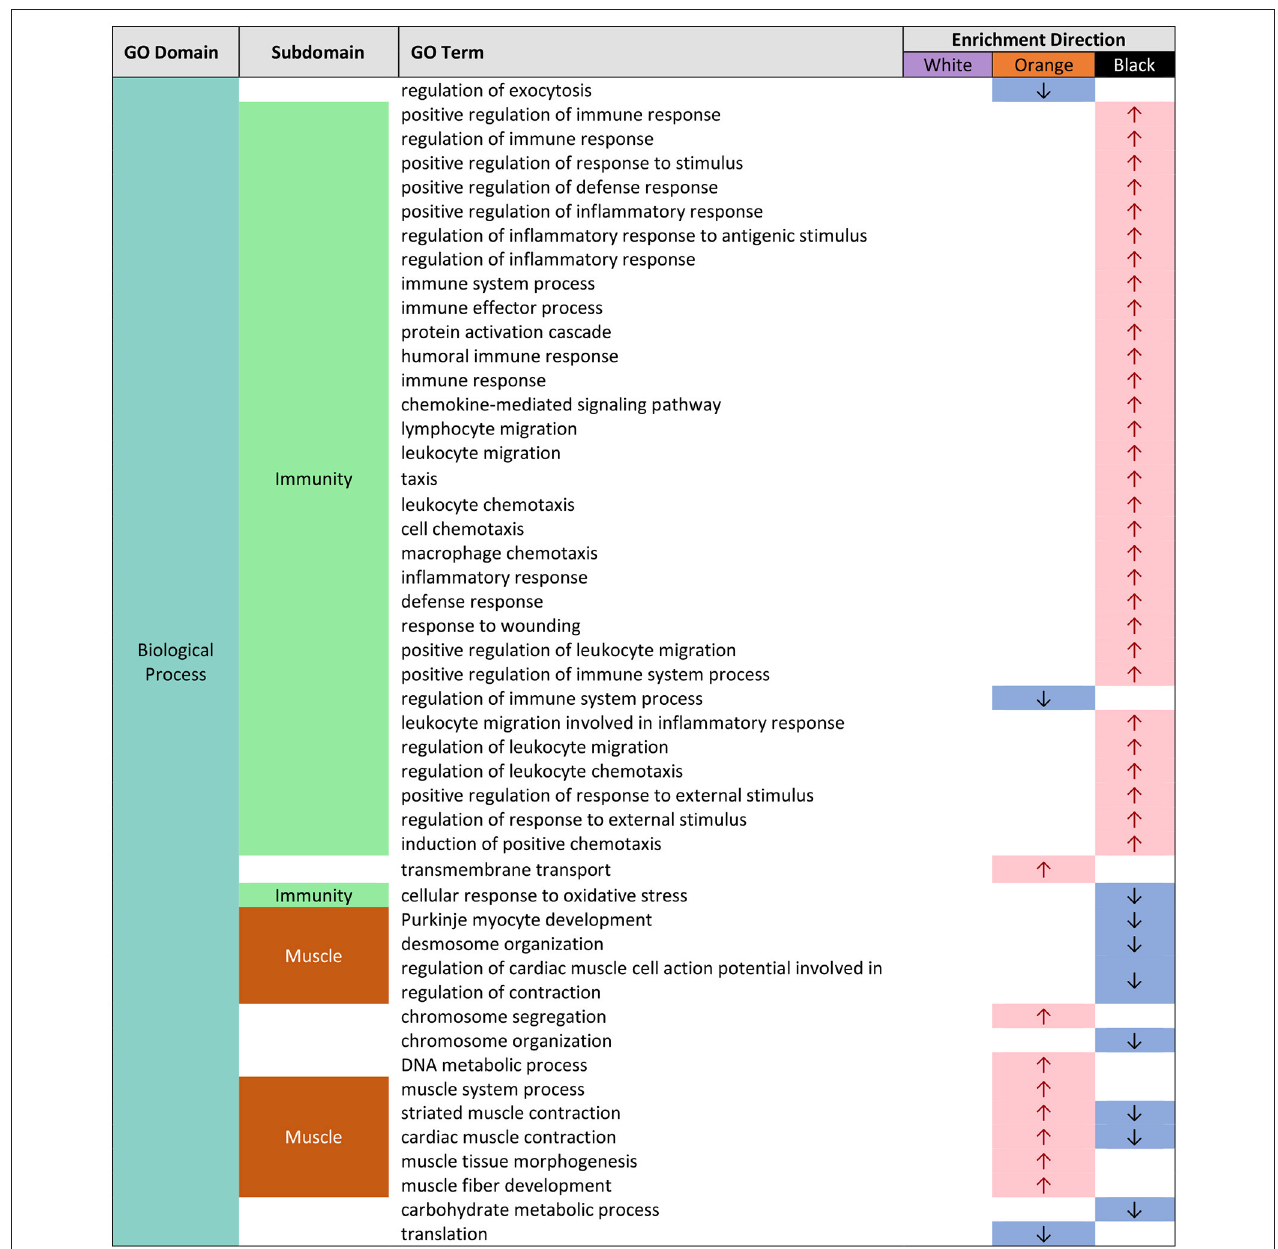
FIGURE 2 | Gene ontology (GO) categories significantly enriched for both pairwise color comparisons for each epidermal tissue by “biological process” (BP) using Mann-Whitney U tests based on ranking of signed log p -values computed using EdgeR . Results indicate the GO domain (BP), the subdomains discussed in text (“immunity” and “muscle”), the specific GO terms, and enrichment direction observed consistently in each epidermal tissue